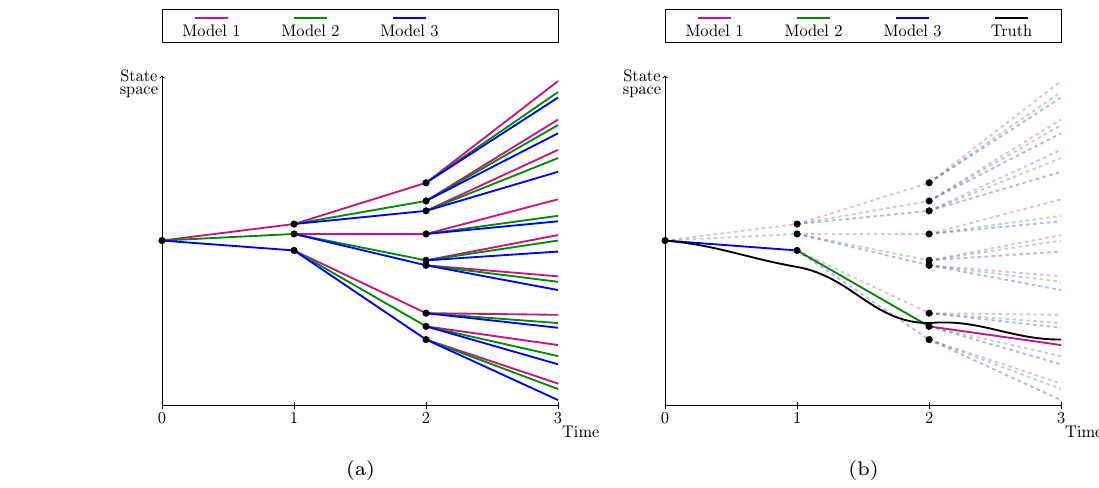
Figure 1. Cross pollination in time for three models, without pruning (a) and with pruning (b) .